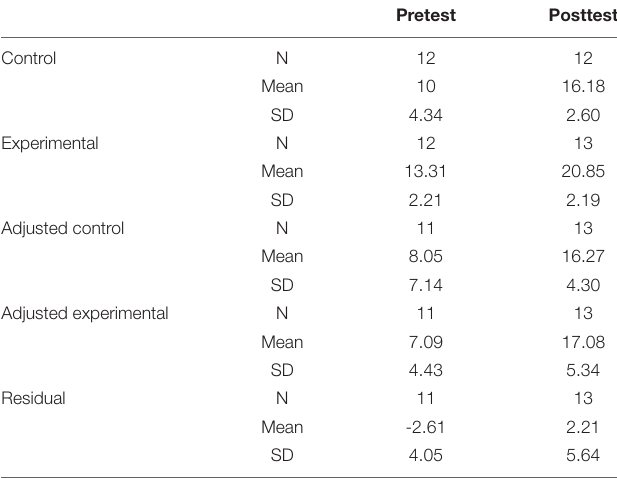
TABLE 5 | Mean and standard deviation, and SD for non-parametric ANCOVA. Pretest Posttest